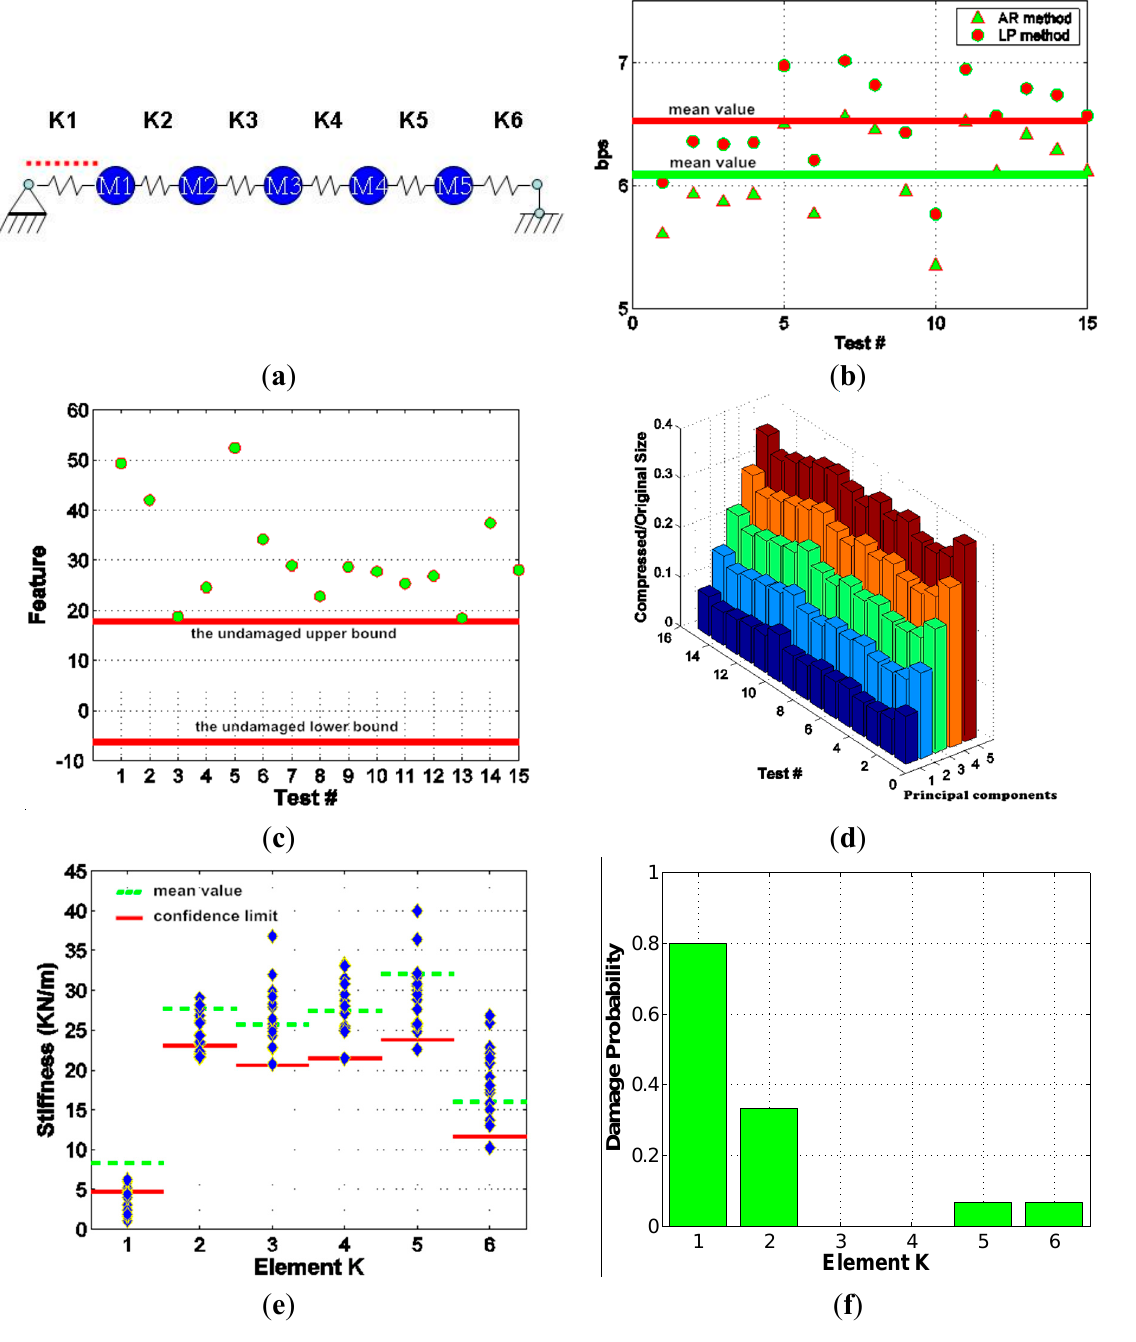
Figure 6. Performance of the Integrated SHM system in Scenario #1 ( a ) Damage at single location; ( b ) Sensor data compression; ( c ) Feature monitoring; ( d ) Progressive data transmission; ( e ) Identified stiffness; ( f ) Statistical analysis of damage.